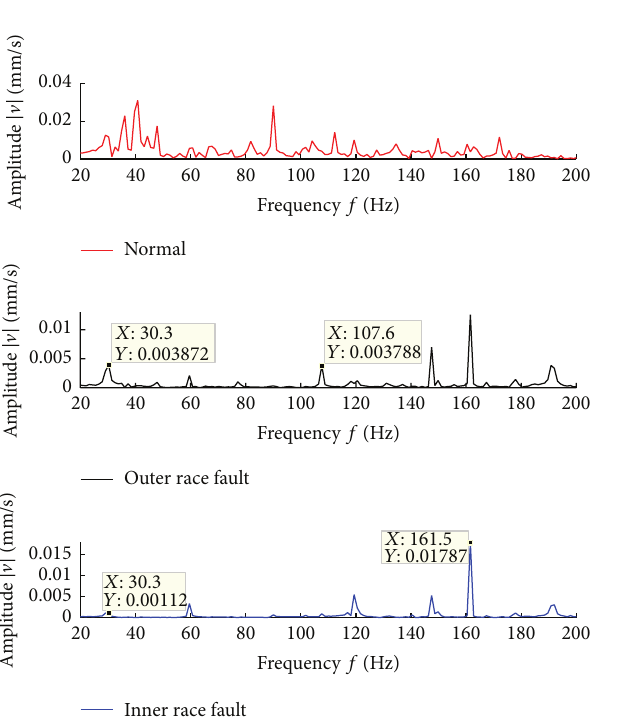
Figure 12: Amplitude spectra of the displacement signals acquired by